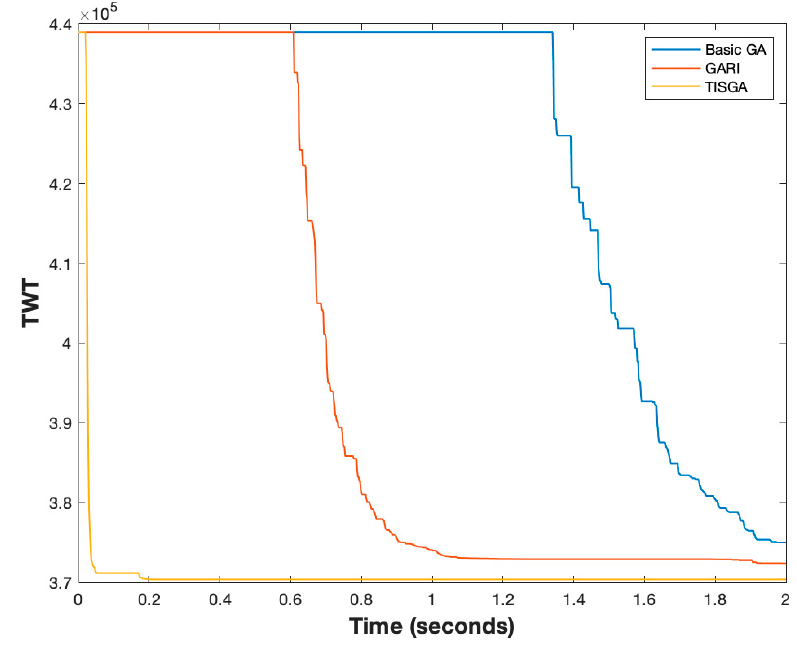
Figure 25. TWT value vs. computation time for TISGA, GARI and basic GA, for instance, with 200 jobs.